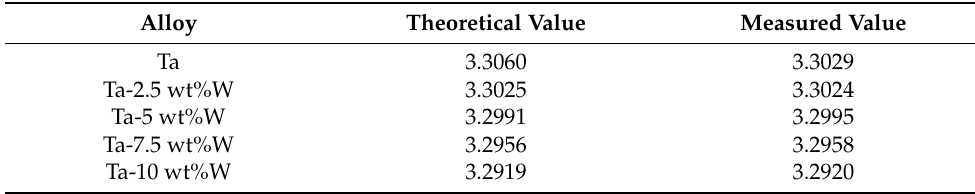
Table 2. Theoretical and measured values of lattice constants of tantalum tungsten alloy.